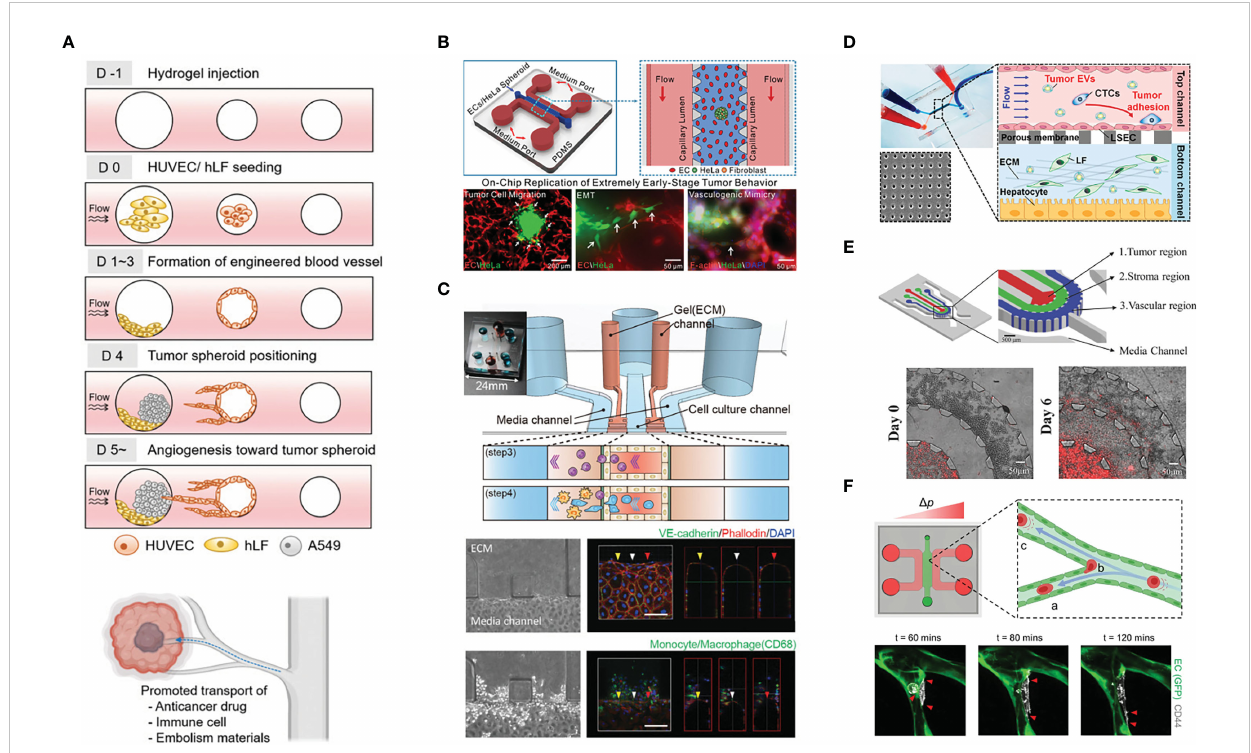
FIGURE 2 Example of the application of vascularized tumor-on-a-chip for mechanistic studies. (A) The study of tumor vascularization by angiogenesis and the promotion of therapeutic transport. Adapted with permission. Copyright 2022 (D) Kim et al. Advanced Healthcare Materials published by Wiley ‐ VCH GmbH. (B) The recapitulation of extremely early-stage tumor dynamics and interaction with blood vessel. Adapted with permission. Copyright 2021, American Chemical Society. (C) Elucidating the role of monocyte/macrophage in forming pre-metastatic niche. Adapted with permission. Copyright 2019 (H) Kim et al. Published by WILEY ‐ VCH Verlag GmbH & Co. KGaA, Weinheim. (D) Investigating the effect of tumor-derived extracellular vesicles in priming the pre-metastatic niche. Adapted with permission. Copyright 2020, American Chemical Society. (E) The concentric three-layer